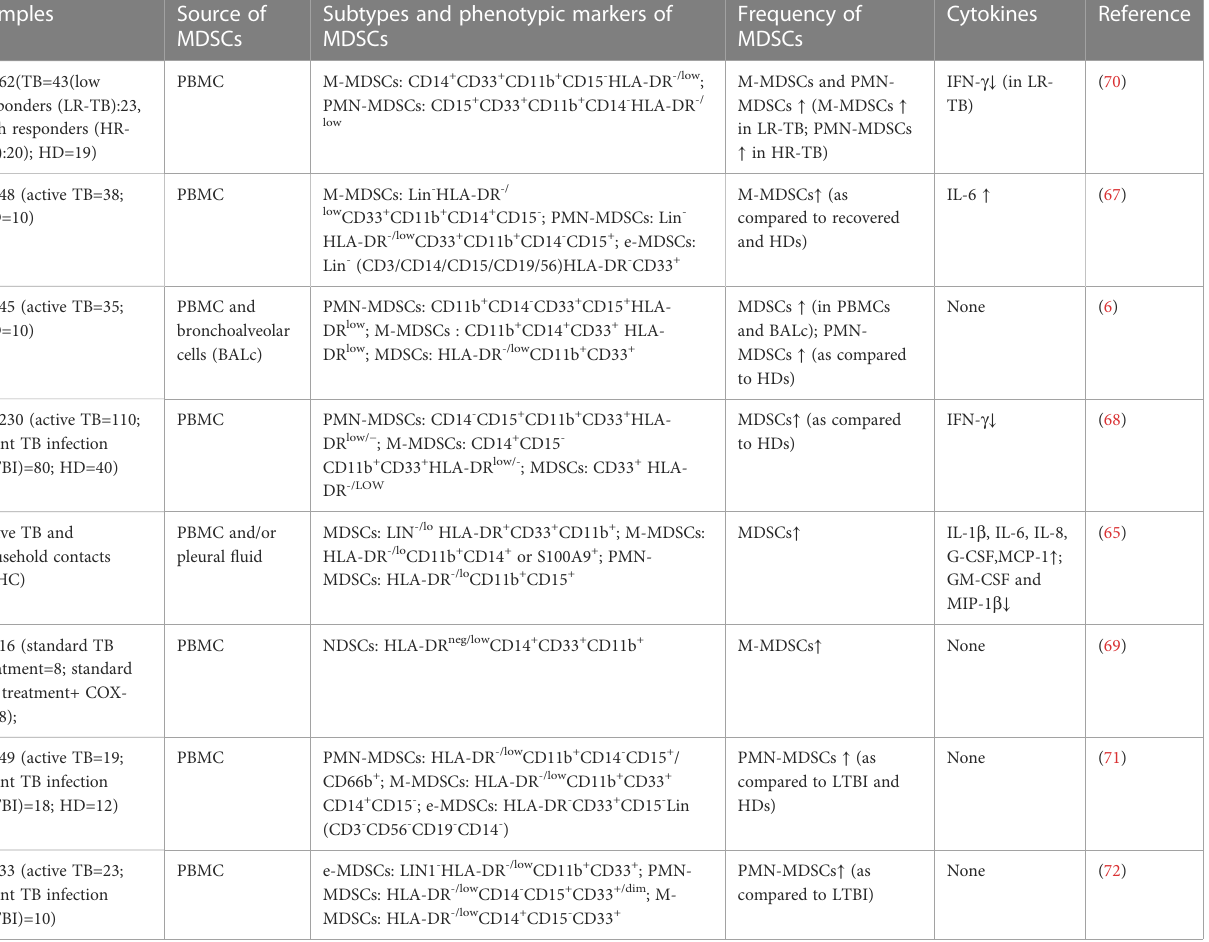
TABLE 2 Summary current studies on MDSCs in tuberculosis patients.